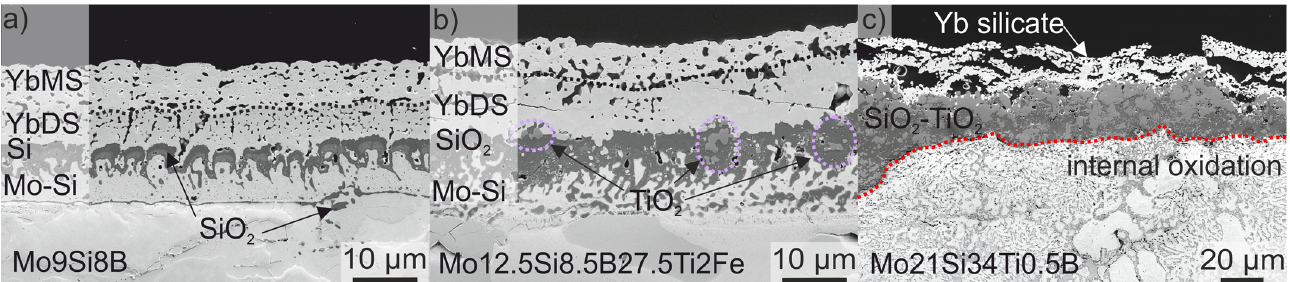
Figure 8. Secondary electron SEM micrographs of the bond coat and the YbDS and YbMS top layer on ( a ) Mo-9Si-8B alloy, ( b ) Mo-12.5Si-8.5B-27.5Ti-2Fe alloy, ( c ) Mo-21Si-34Ti-0.5B alloy after 100 h of oxidation test at 1200 °C in air.